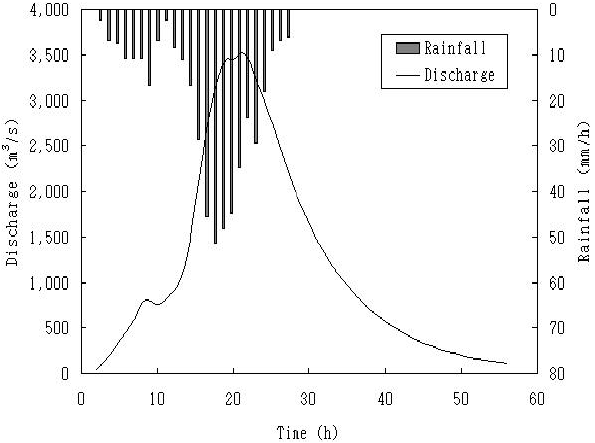
Fig. 5. Discharge hydrograph at bank break point (rainfall data: WAter Management Information System, http://www.wamis.go.kr/)